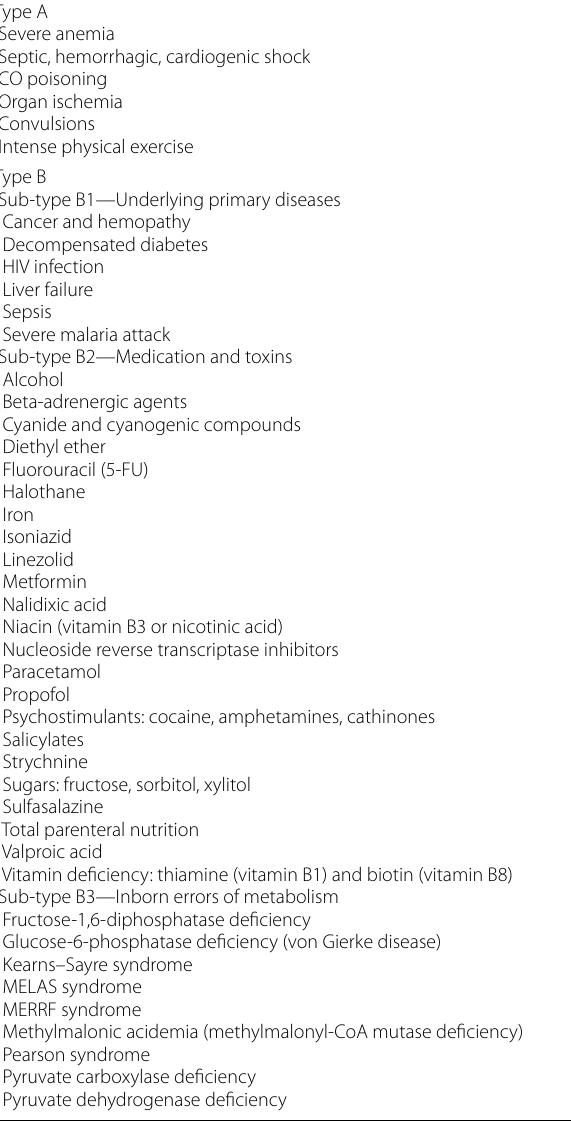
Table 3 Main causes of hyperlactatemia